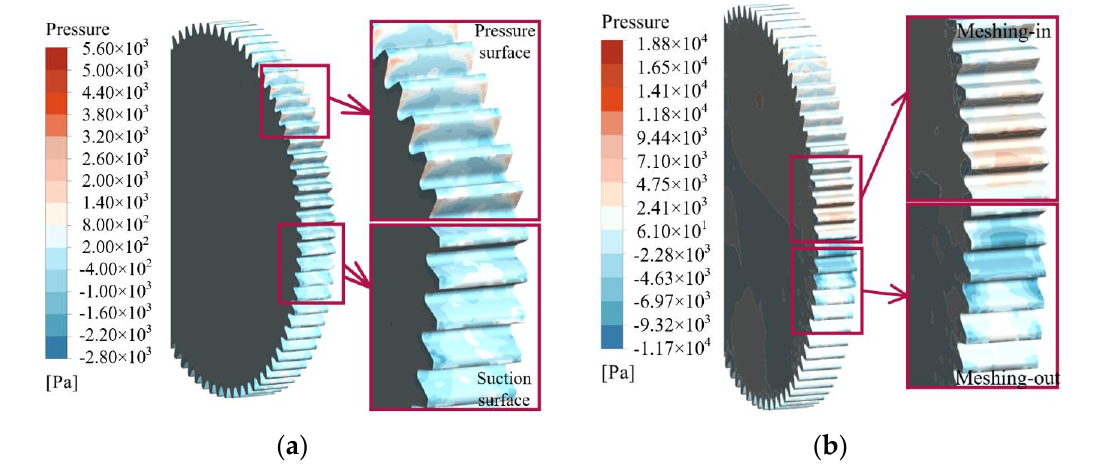
Figure 6. Pressure surface and suction surface: ( a ) Simulation of a single gear; ( b ) Simulation of a gear pair.